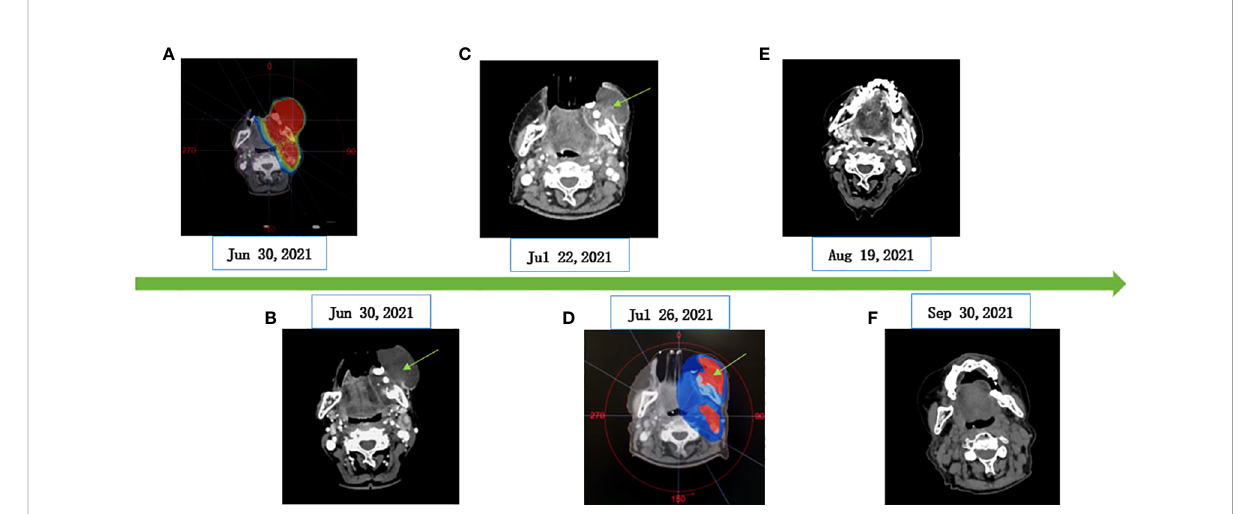
FIGURE 3 CT imaging of changes of gingival masses. (A) RT dose distribution image. (B) Before CRT (62 mm×53 mm×64 mm). (C) CRT and crizotinib for 1 week (50 mm×32 mm×42 mm). (D) Adjust the radiotherapy area (gingival mass: 8mm×27mm×46mm). (E) CRT and crizotinib for 1 month (undetectable tumor size). (F) Oral crizotinib for 2 months (ef fi cacy evaluation as